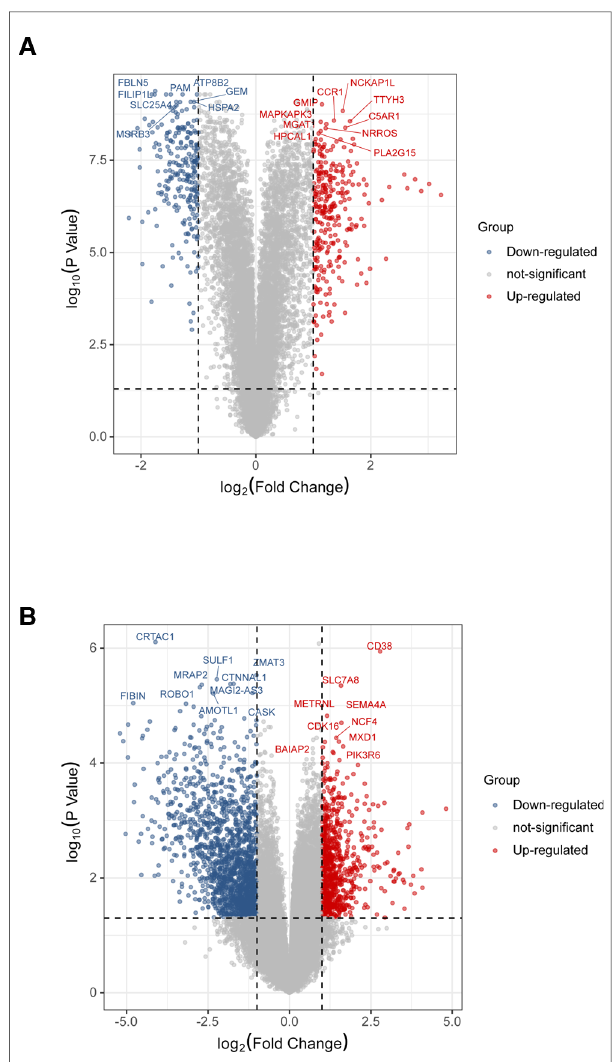
FIGURE 4 Identi fi cation of DEGs in validation cohort. ( A ) Volcanic plot of a total of 499 DEGs in GSE163154 including 270 upregulated and 229 downregulated genes. The y-axis represents the − 1og 10 ( P- value) and the x-axis represents the gene fold change (log 2 FC). Blue and red colors dots represent low and high expression, respectively. ( B ) Volcanic map of 1,795 DEGs, including 1,159 downregulated genes and 636 upregulated genes, identi fi ed from ruptured AP samples in the GSE41571 dataset. DEGs, Differential Expression